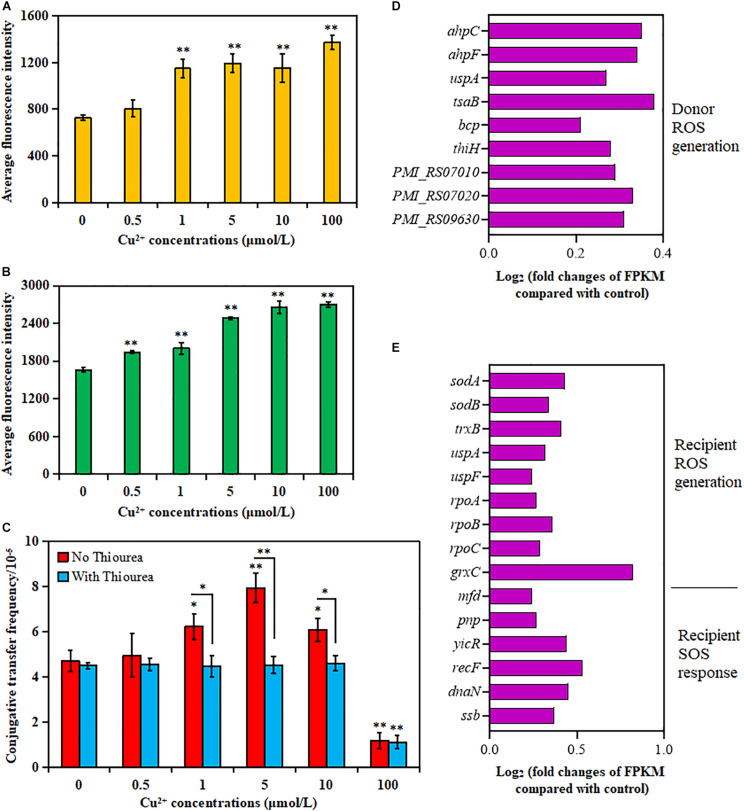
Effects of Cu2+ on reactive oxygen species (ROS) production in the donor (Proteus mirabilis ChSC1905) and recipient (Escherichia coli EC600). Average fluorescence intensity of ROS production in (A) the donor and (B) the recipient checked by flow cytometer. (C) Effect of ROS scavenger (thiourea) on the conjugative transfer of SXT/R391 integrative and conjugative element (ICE) from the donor to the recipient. Fold changes of the expression of genes related to ROS generation and SOS response in (D) the donor and (E) the recipient. p < 0.05 indicated a statistically significant difference (*p < 0.05; **p < 0.01).